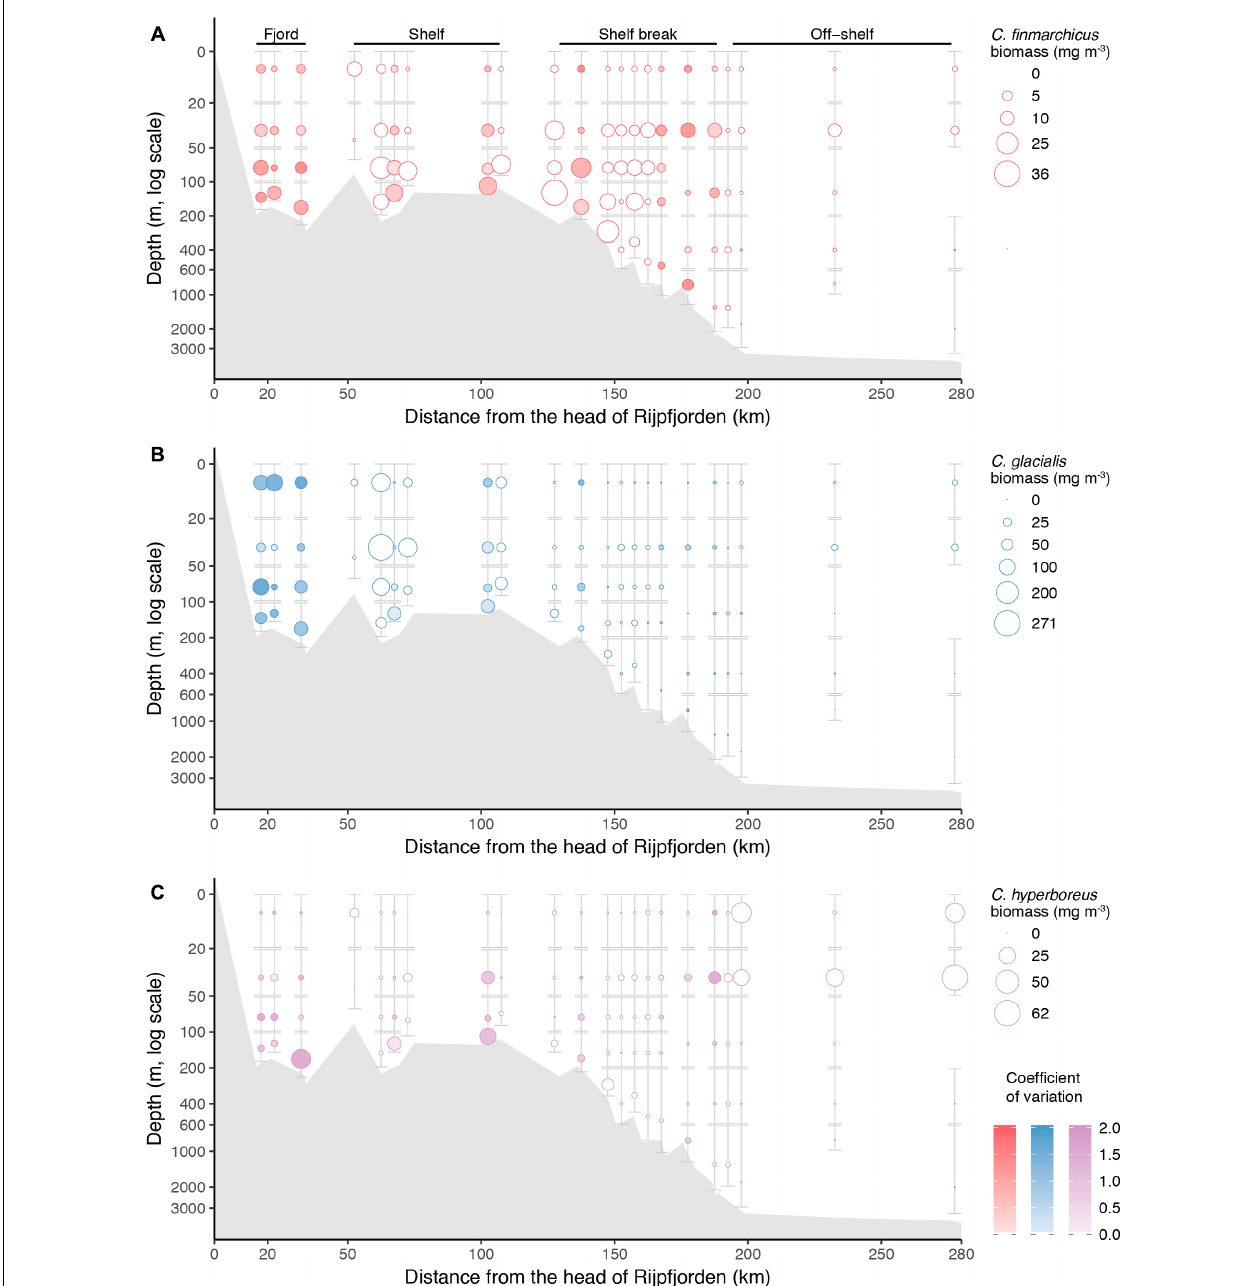
FIGURE 11 | Biomass (mg m − 3 ) of the three Calanus species along the transect from Rijpfjorden to the Arctic Ocean with data from all years combined. (A) C. finmarchicus , (B) C. glacialis , and (C) C. hyperboreus . See Figure 10 for explanation of figure elements.